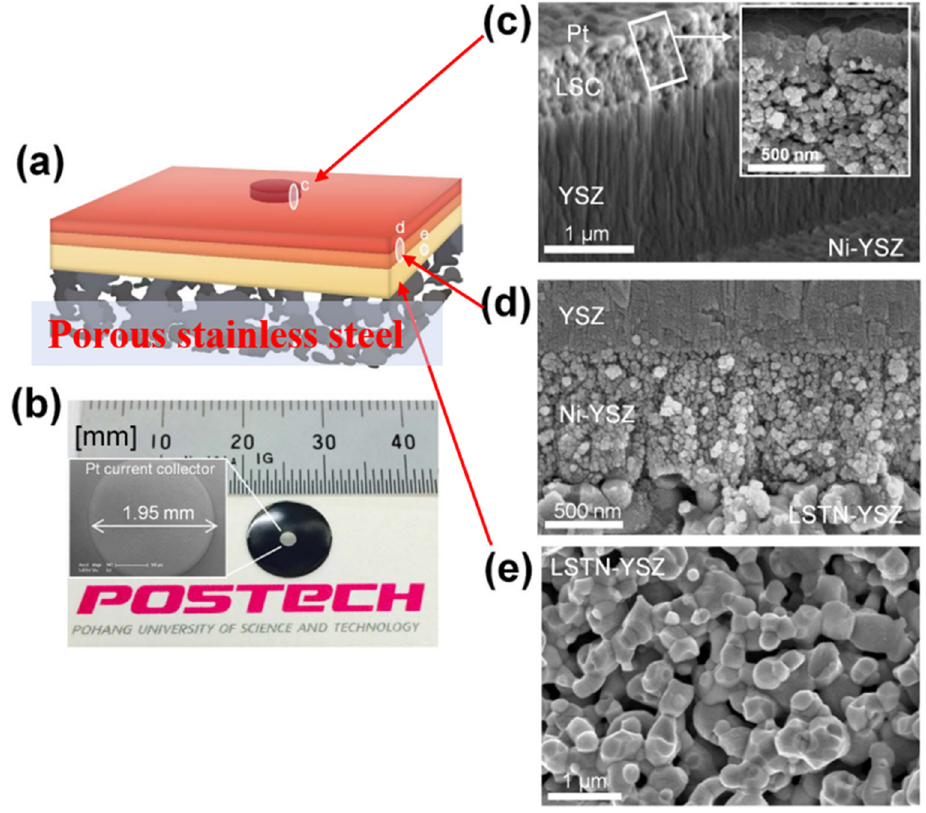
Figure 15. Images of TF-MSC. ( a ) structure diagram; ( b ) morphology and size; ( c – e ) Microstructure of the corresponding positions in ( a ). Reproduced with permission from Ref.